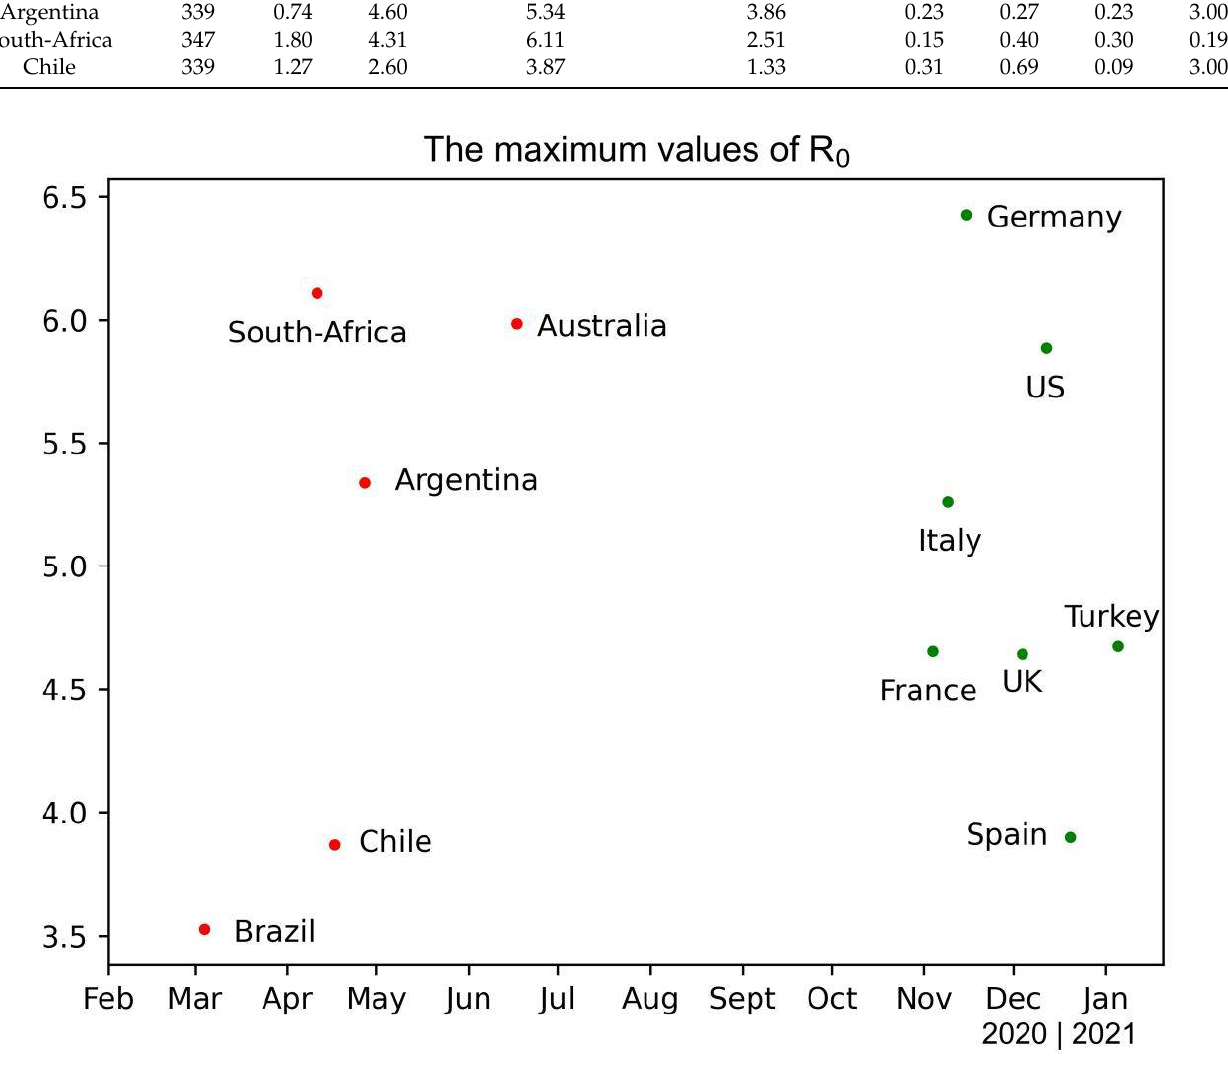
Figure 2. The maximum values of R 0 of the selected